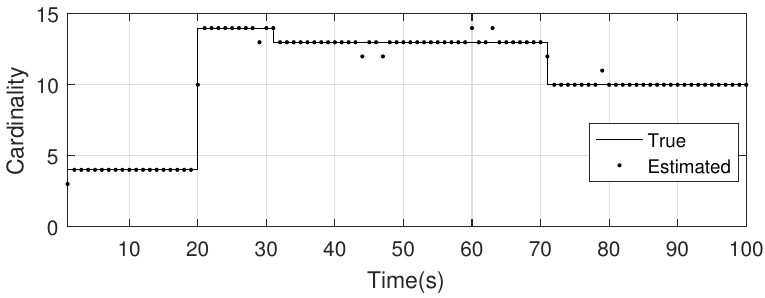
Figure 17. The estimated number of targets by GLMB filter.